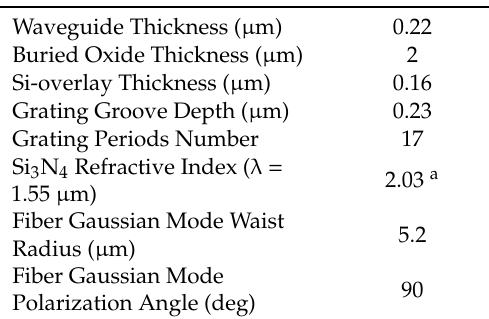
Table 1. Main parameters used in simulations at 300 K.